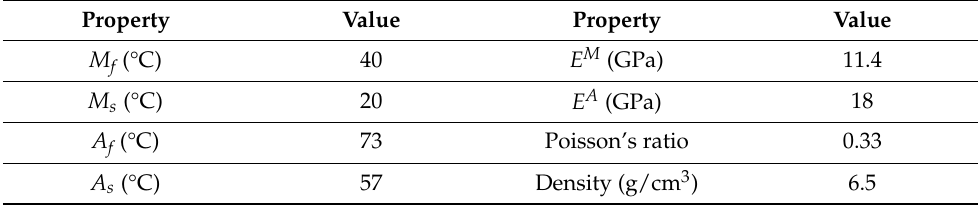
Table 1. Material properties for SMA strips.